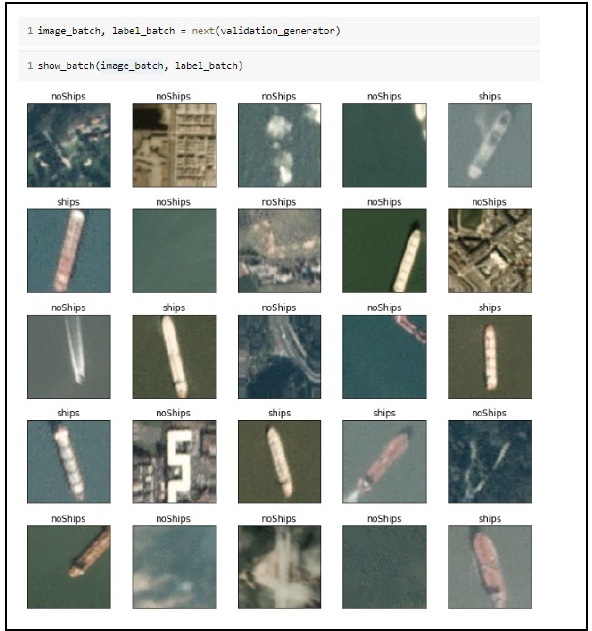
Figure 2. Sample set of image training images and labels